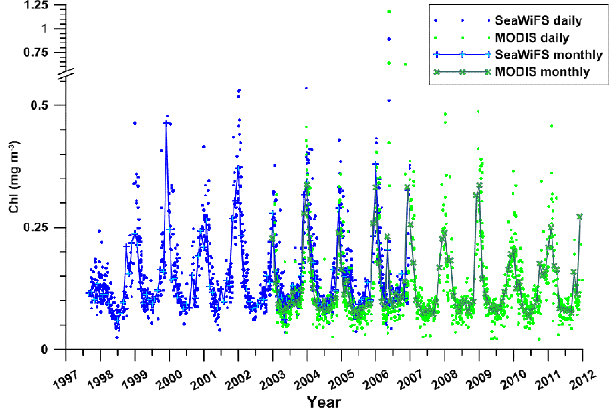
Fig. 3. Time-series of sea surface chlorophyll a (Chl) data from SeaWiFS (blue) and MODIS (green). The dots represent daily data; the crosses represent the monthly data.